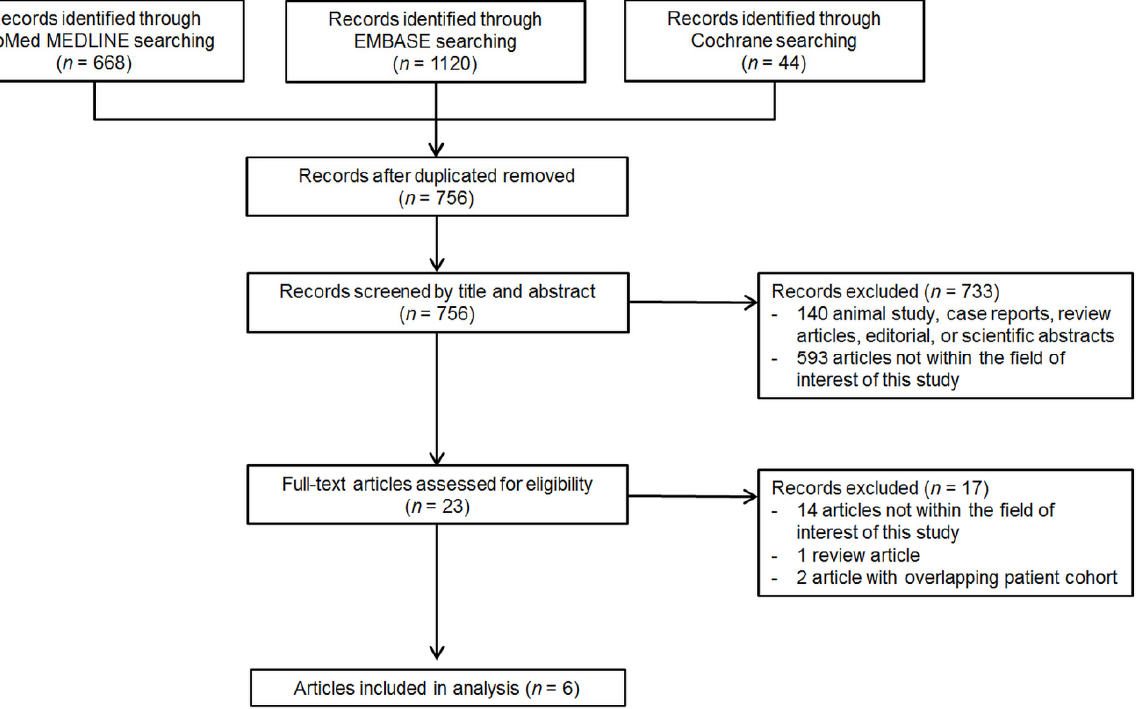
Figure 1. PRISMA flow diagram of article selection.